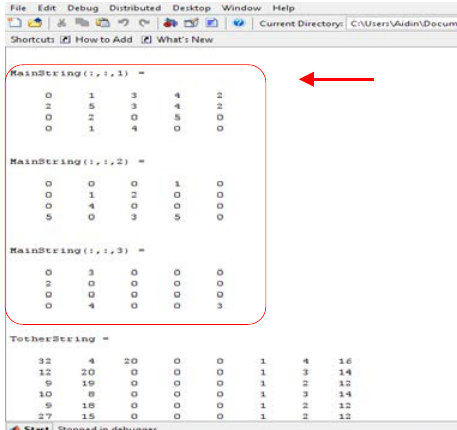
Fig. 6. Result of Using the best Part routes of an Invited Member from the Tournament List as Tother String (right